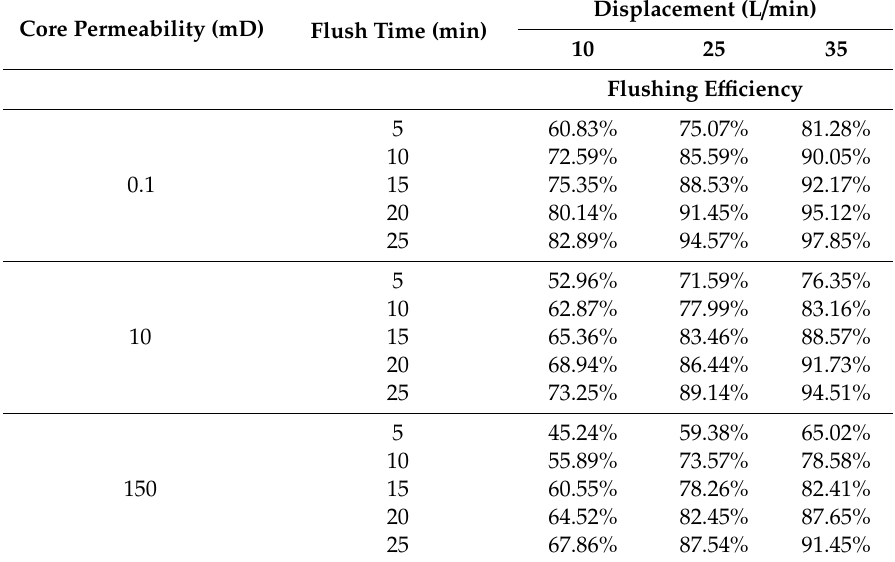
Table 3. Flushing e ffi ciency results under di ff erent flushing displacement and time. Core Permeability